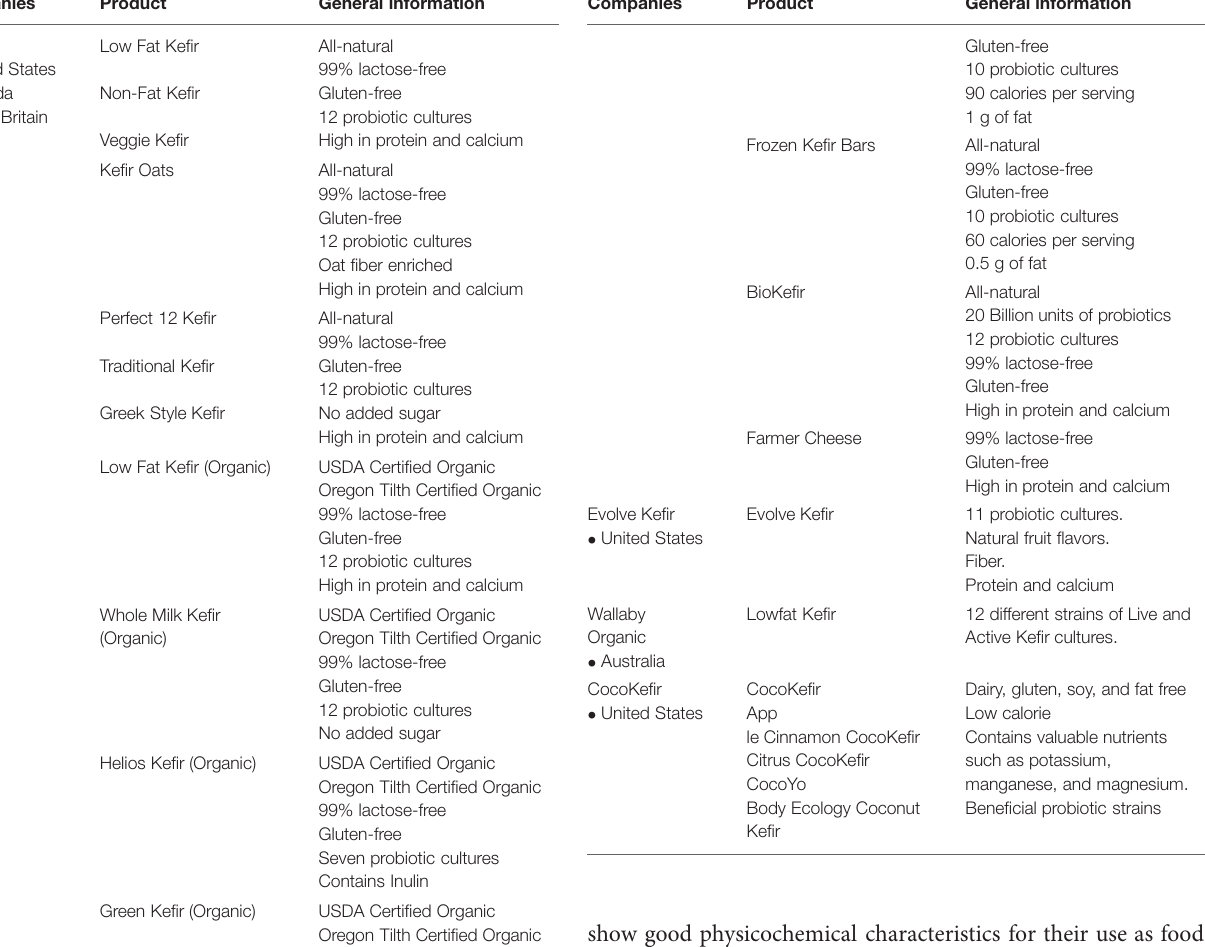
TABLE 4 | Marketed kefir-based products and their information.